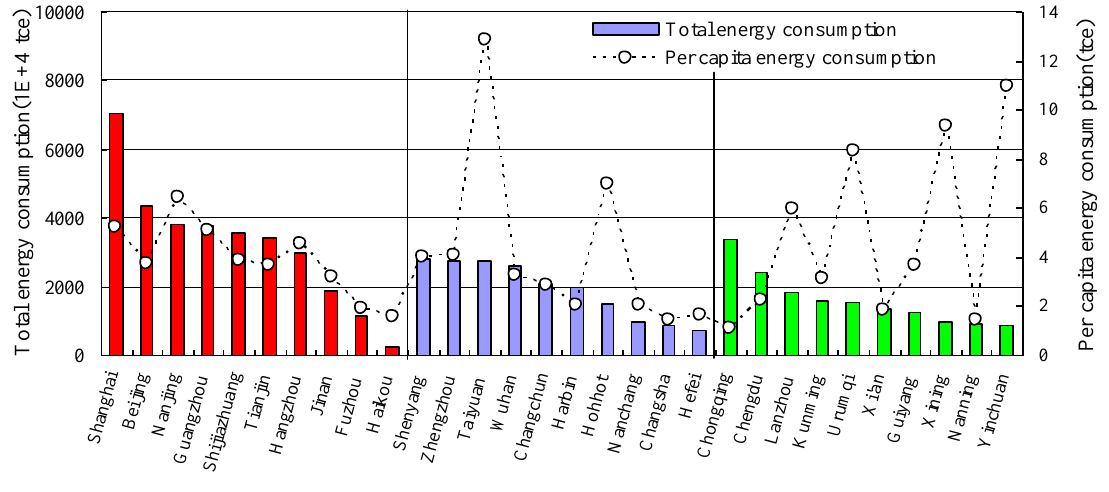
Figure 1. The total and per capita energy consumption of 30 provincial capital cities in China in 2005.